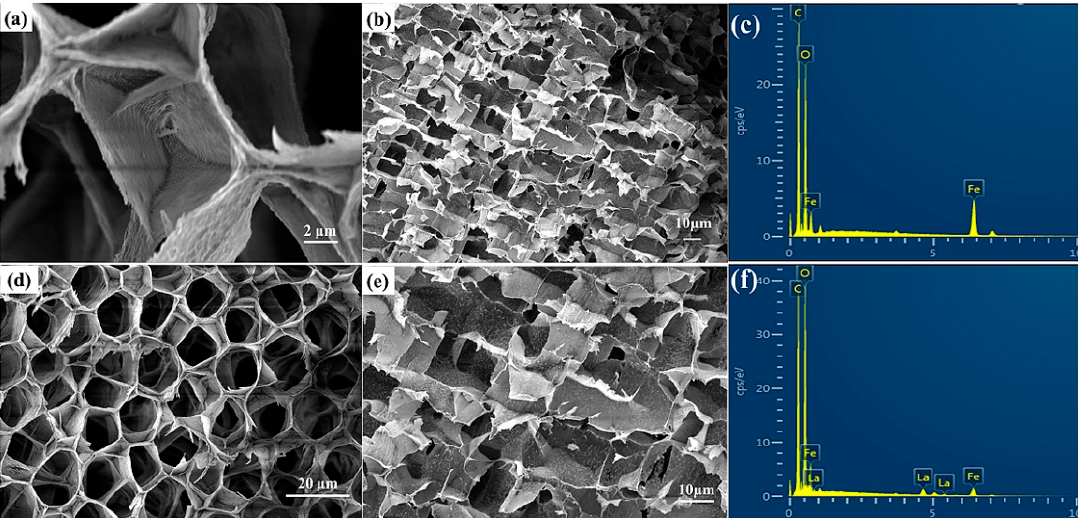
Figure 1. SEM images and EDS diagrams of the as-prepared chitosan magnetic spheres ( a – c ) and La-chitosan magnetic spheres ( d – f ).